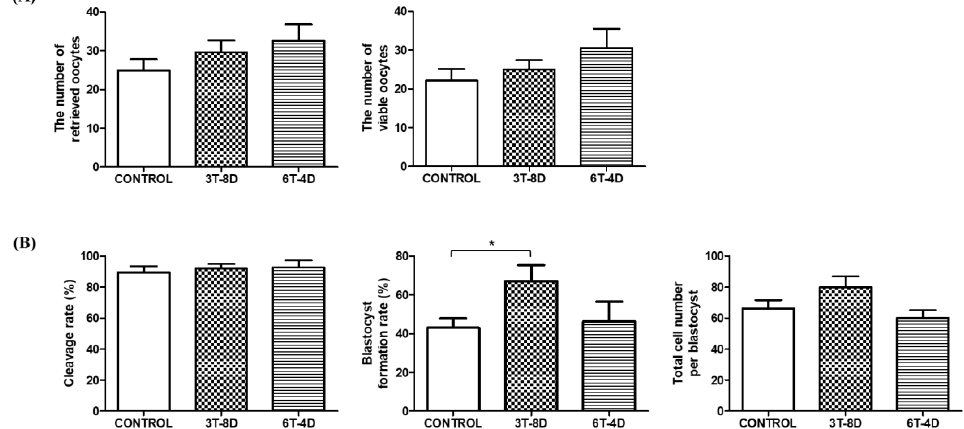
Figure 2. Evaluation of ( A ) ovulation status and ( B ) embryo development competence after parthenogenetic activation from the control and groups of human adipose-derived stem cell conditioned medium (ASC-CM) intravenous injection in 4-month-old mice. Data are expressed as the mean ± standard error of the mean (SEM). * p < 0.05. 4D-6T, six times injection in four day intervals; 8D-3T, three times injection in eight day intervals. Animals 2020 , 10 , x FOR PEER REVIEW